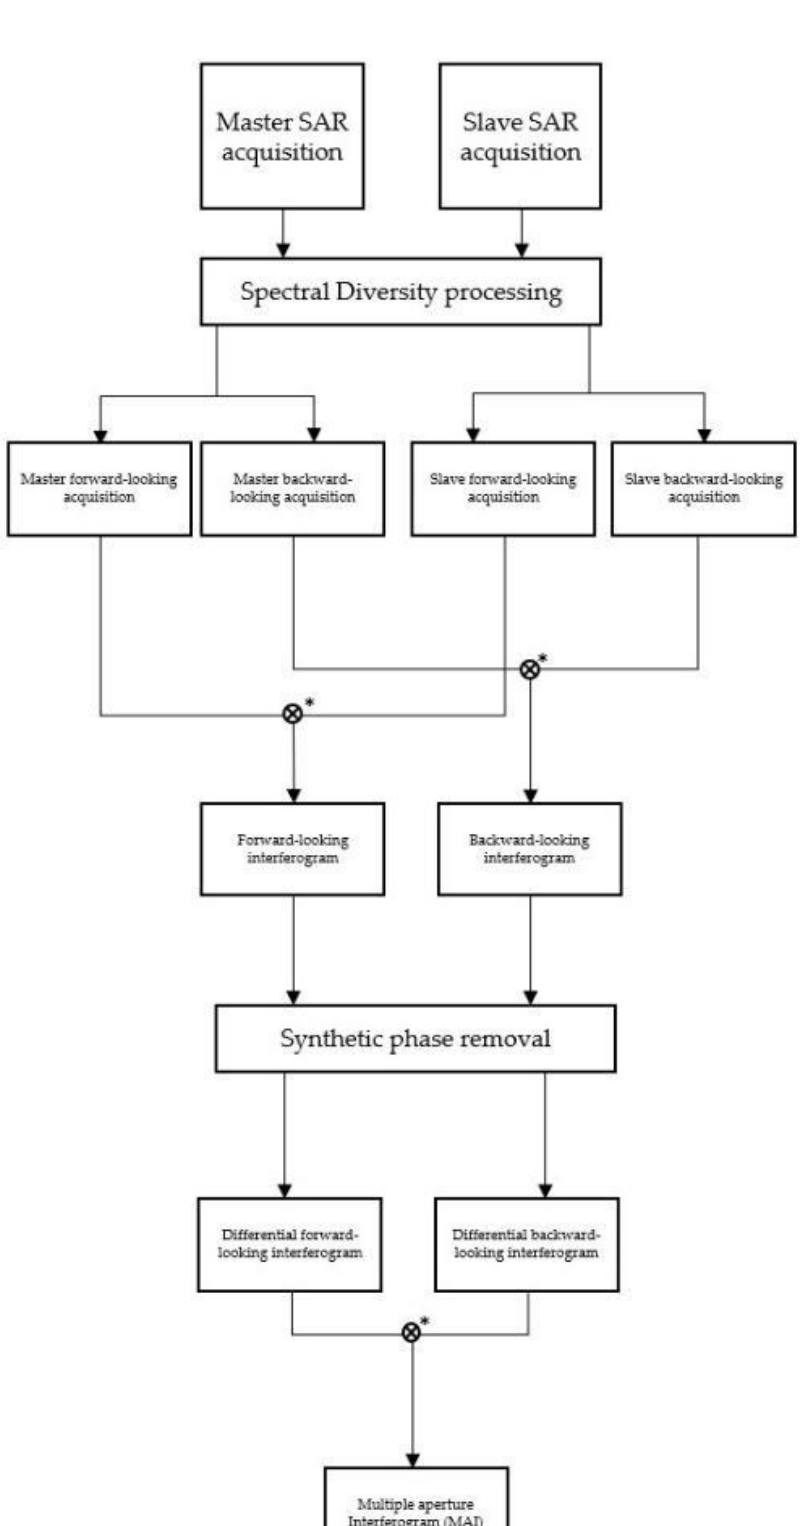
Figure 13. MAI processing flowchart. The symbol * denotes a complex conjugate multiplication.